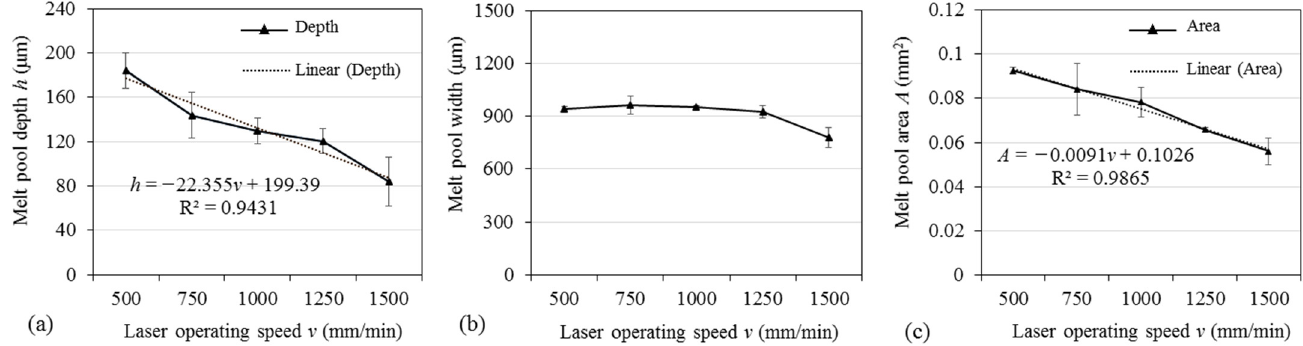
Figure 4. Depth ( a ), width ( b ) and area ( c ) of melt pool obtained by laser processing at 0.5 mm laser spot diameter with boron in relation to laser operating speed.